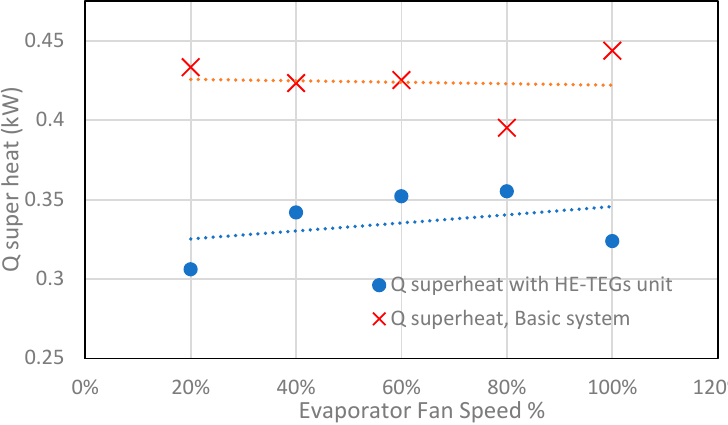
Figure 7. Variation of Q-superheat with evaporator fan speed with and without HE-TEGs unit.